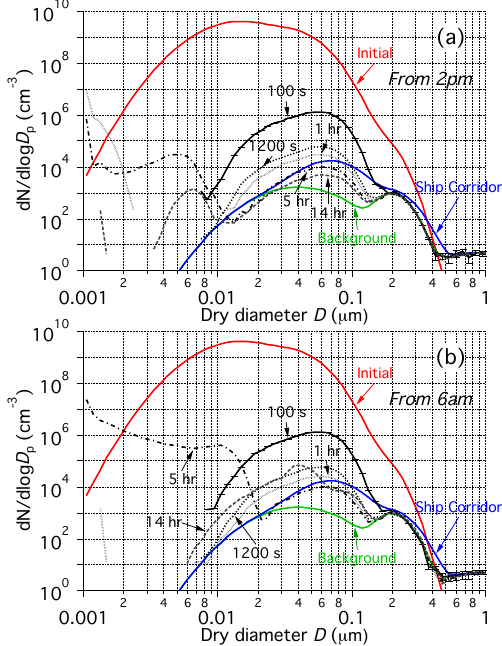
Fig. A1. (a) Comparison of simulated number concentrations from Figure A1. (a) Comparison of simulated number concentrations the base case with nucleation to the observed data obtained during from the base case with nucleation to the observed data obtained the single plume study on 14 June 2007 during the QUANTIFY during the single plume study on 14 June 2007 during the QUAN- SHIPS campaign. The red dot indicates the initial aerosol number TIFY campaign. The red dot indicates the initial aerosol number concentration. The horizontal error bars represent the estimated er- concentration. The horizontal error bars represent the estimated er- rors in determining plume ages. (b) Simulated number concentra- rors in determining plume ages. (b) Simulated number concentra- tions from the base case during the entire simulation period with nu- tions from the base case during the entire simulation period with nu- cleation for particles in the range of 10–2000nm and below 10nm. cleation for particles in the range of 10–2000nm and below 10nm.